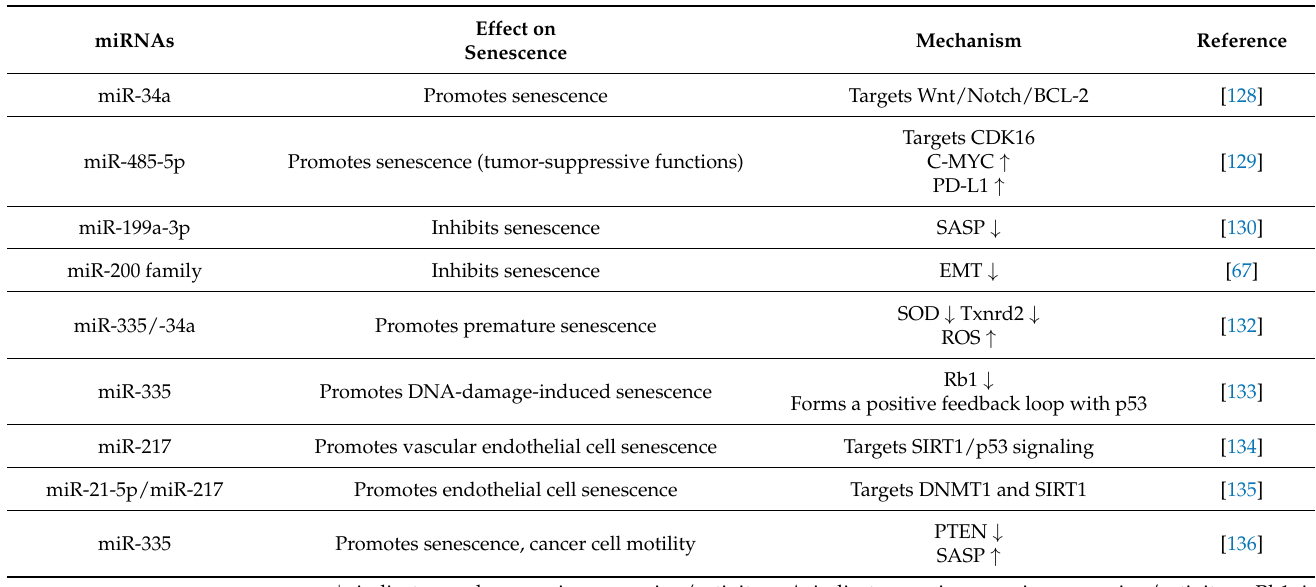
Table 1. Roles of miRNAs in senescence and the